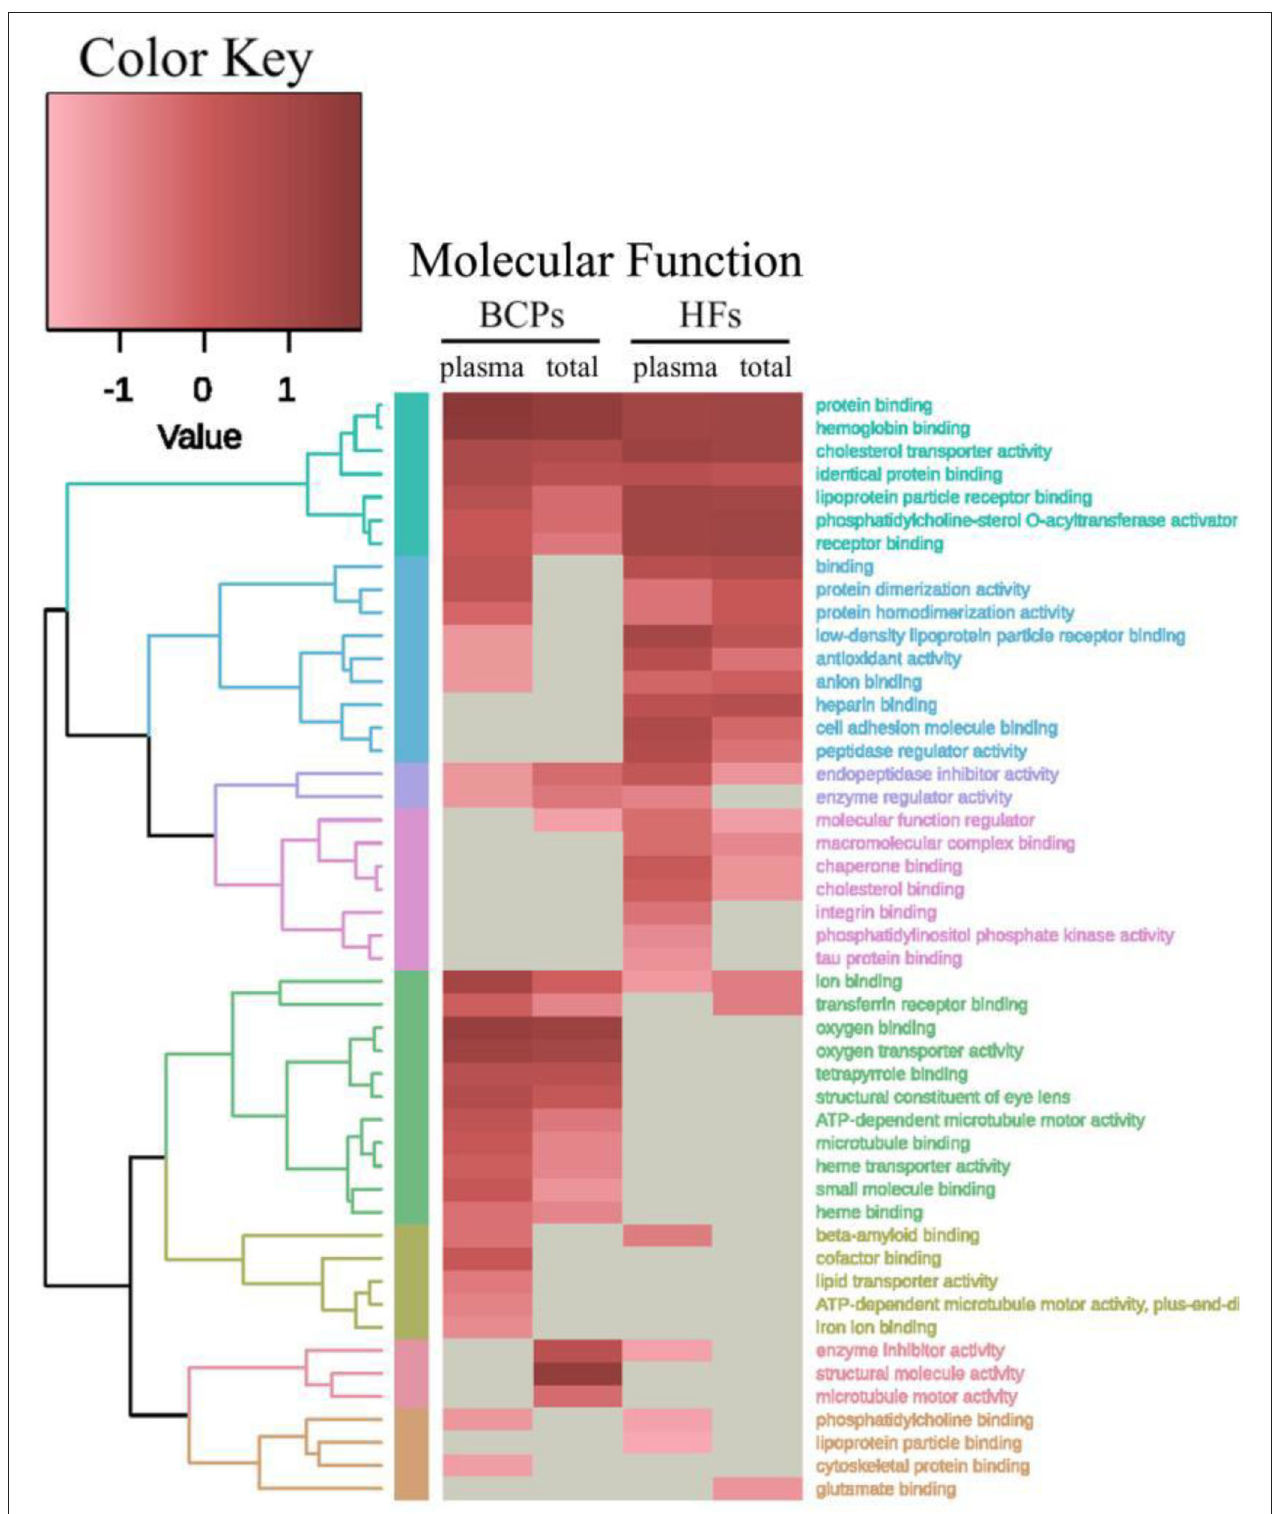
FIGURE 6 | Heat map and dendrogram of the results of GO functional enrichment analysis of exosomal proteins from BCPs and HFs by Molecular Functions obtained via STRING (https://string-db.org/) and visualized using R (https://www.r-project.org/).